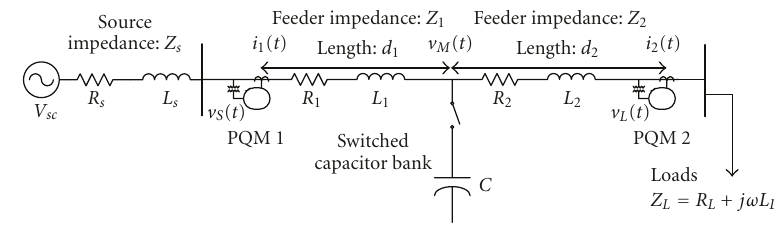
Figure 1: One-line diagram for a typical utility distribution